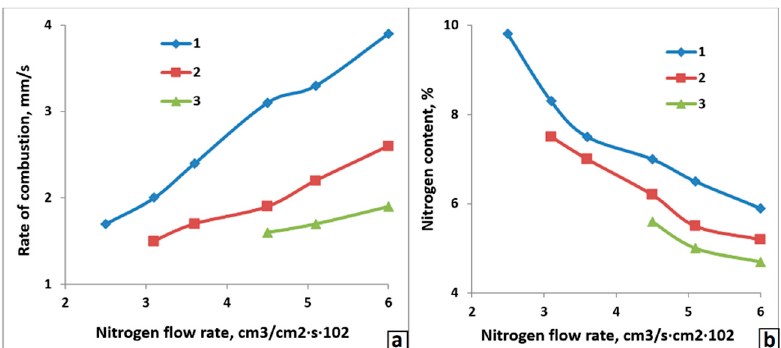
Figure 15. ( a ) Impact of the specific flow rate of N 2 on the combustion rate, and ( b ) degree of nitridation of Fe-Cr and Cr. 1—Cr, 2 and 3—Fe-Cr. 1 and 2—particle size of 63–80 µm, and 3—particle size of 63–200 µm.